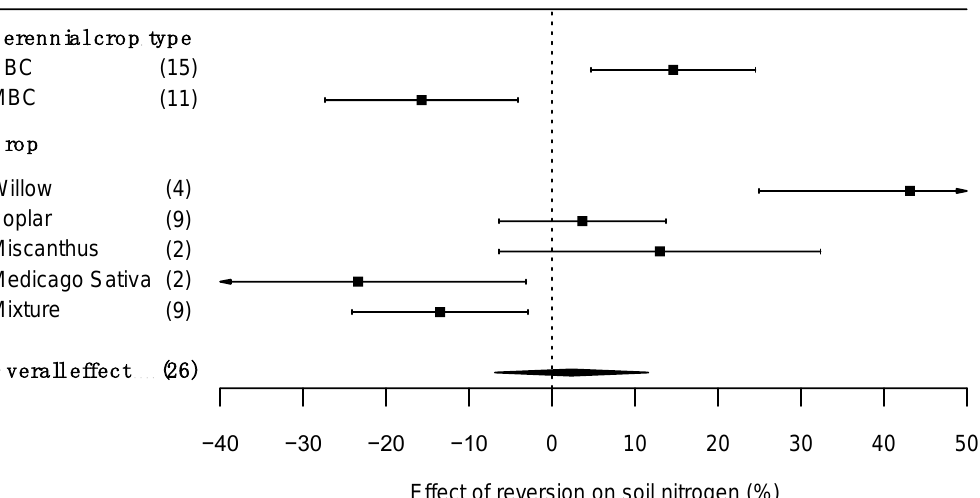
Figure 3. Percentage change of nitrogen stocks (Mg N ha − 1 ) after the reversion of perennial crops according to perennial crops type (PBCs and MBC) and crop species. Error bars represent the 95% Confidence Intervals. Parenthesis indicates the number of observations used to calculate the effect size.